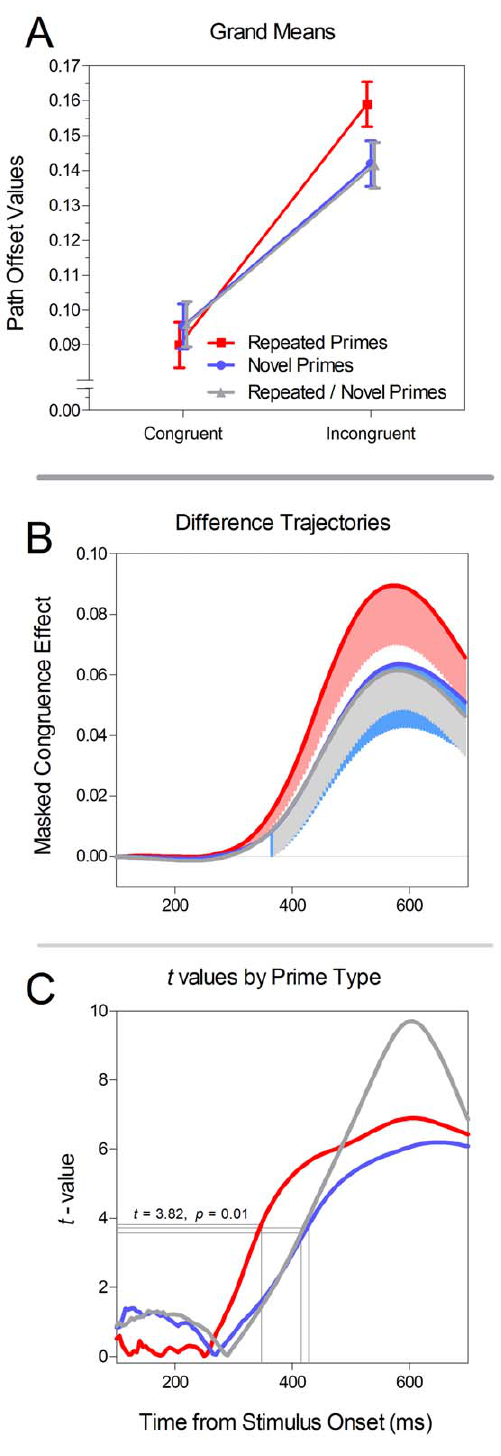
Figure 7. Results from Experiment 2. In Panel A, the grand means by Prime Type and Prime Congruence are depicted. In Panel B, the difference trajectories (incongruent – congruent) are depicted for each Prime Type. The shaded regions indicate 95% confidence intervals that do not include zero (i.e. a significant MCE). Panel C depicts the observed t -values for each Prime Type. The critical t -values are depicted by grey lines.